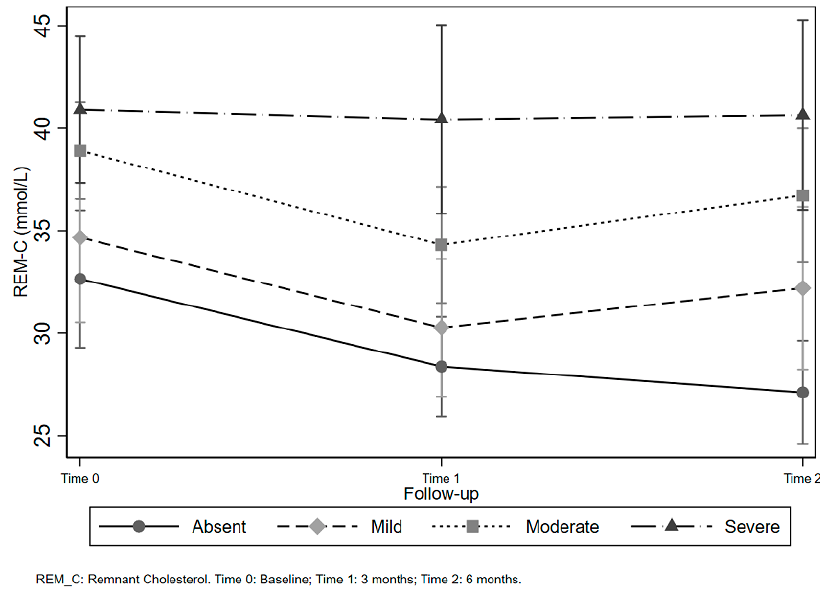
Figure 3. Remnant cholesterol levels by non-alcoholic fatty liver disease severity and time.